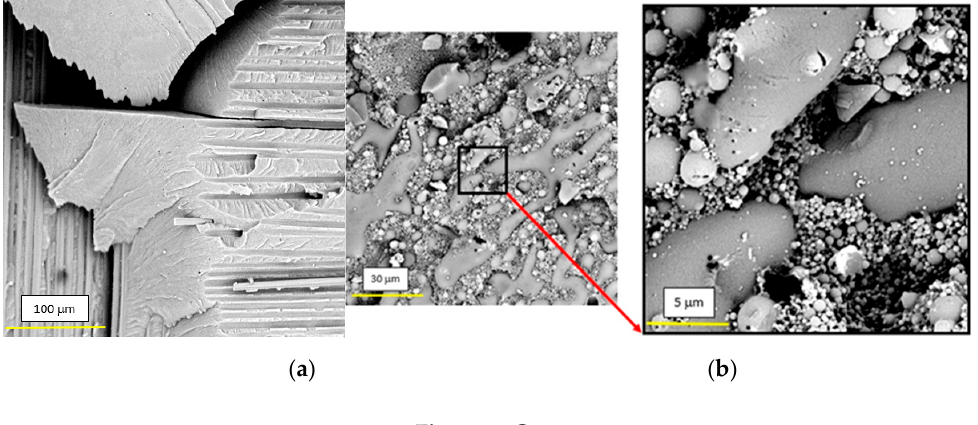
Table 5. The influence of PCL film, Nylon 66 nanofibrous mat, and their mixture on G IIC [39].